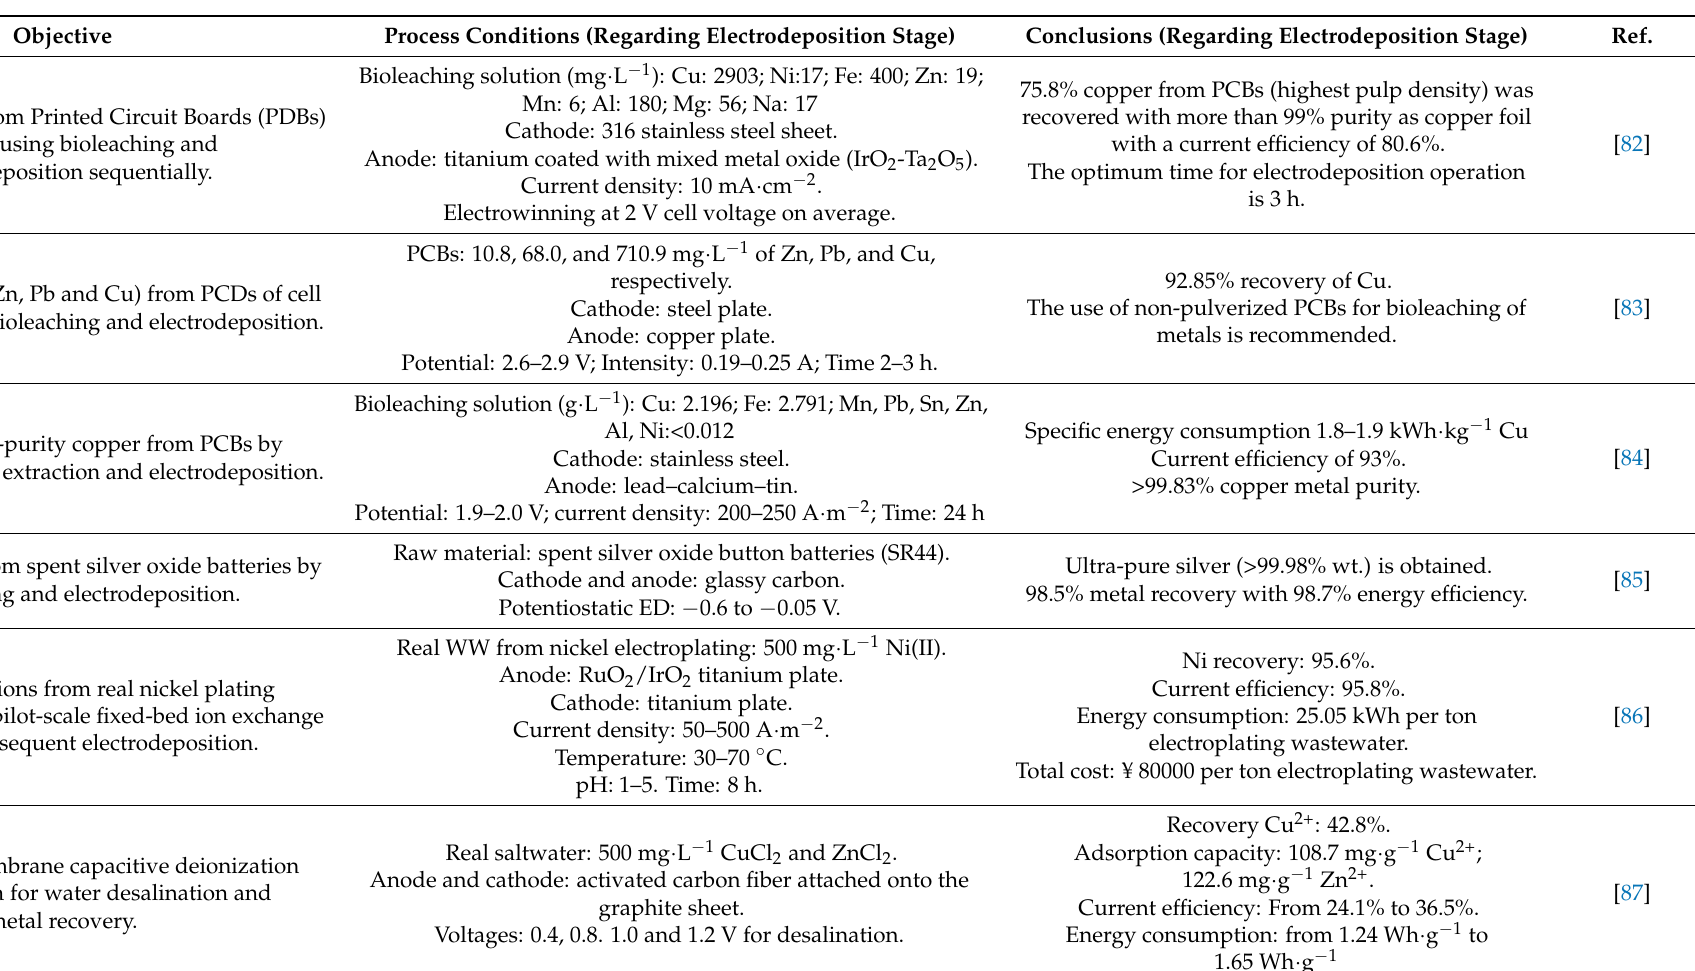
Table 4. Integration of electrodeposition with other processes for metal recovery. Objective Process Conditions (Regarding Electrodeposition Stage) Conclusions (Regarding Electrodeposition Stage)